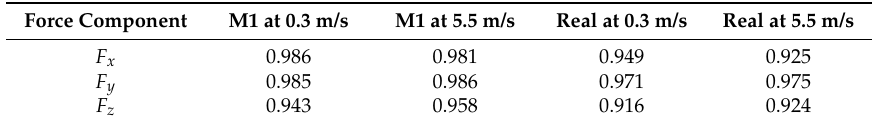
Table 2. Linear correlation coefficients between the aerodynamic forces and the dynamic pressure forces for the rigid and real model at different forward